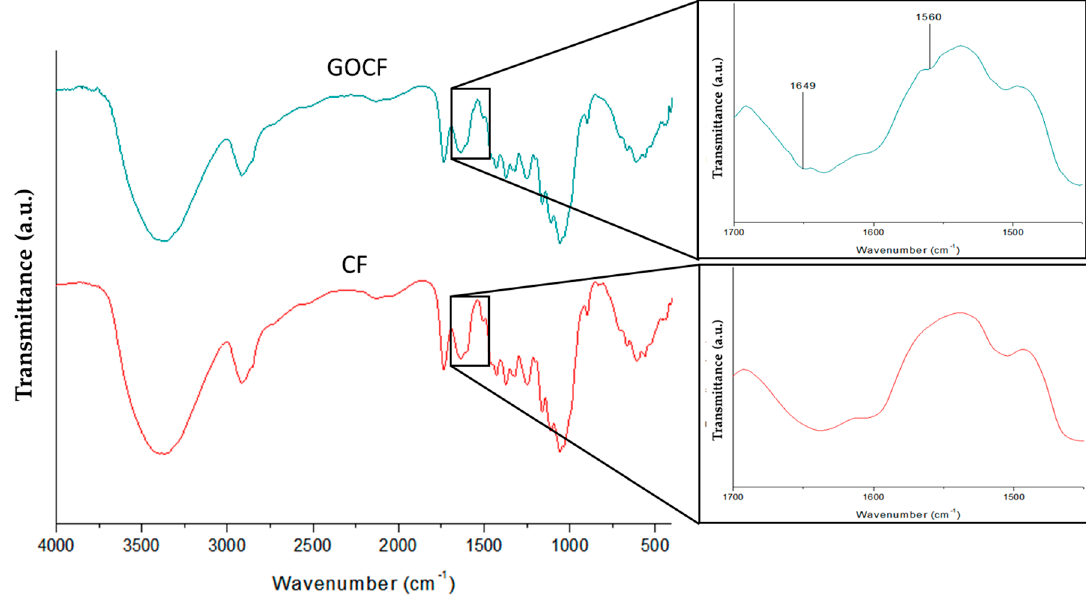
Figure 5. FTIR spectrum of CF and GOCF fibers.